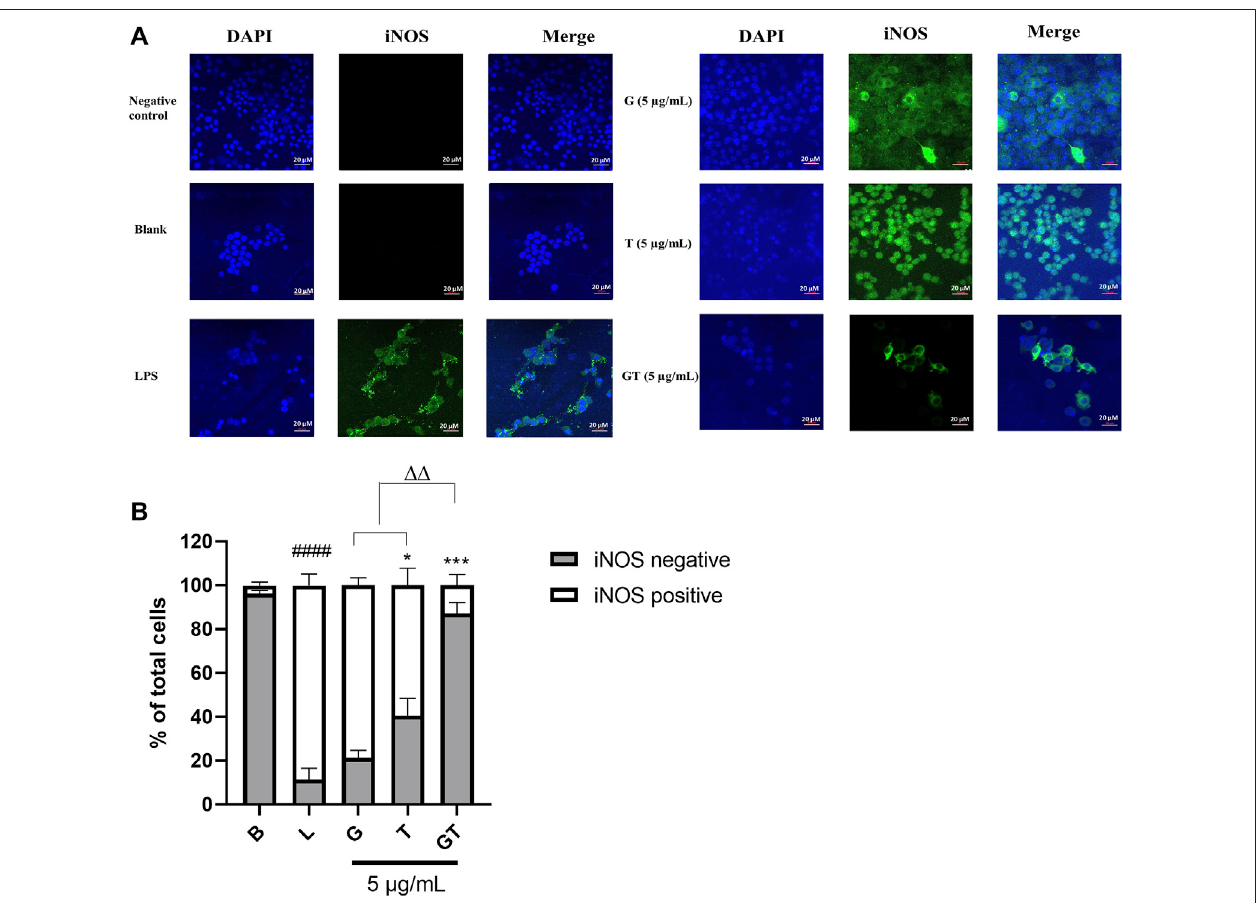
FIGURE2| G, Tand G-T5:2 inhibited LPS activated iNOS expression inthe RAW 264.7cells byimmuno fl uorescence stainingofiNOS (A) Representative images ofiNOSgreen fl uorescentexpressionweretakenbyusingaconfocalmicroscopewith40×magni fi cation.Blue:DAPIinthenucleus,green:iNOSintheRAW264.7cells. (B) QuantitativeanalysisofiNOSpositiveandnegativeexpressionsbasedonthe fl uorescentstaining.#### p < 0.05ofiNOSpositivecomparedwithblank (B) .* p < 0.05of iNOS positive compared with LPS (L). *** p < 0.001 of iNOS positive compared with L. ΔΔ p < 0.01of iNOS positive of GT compared with G and T.